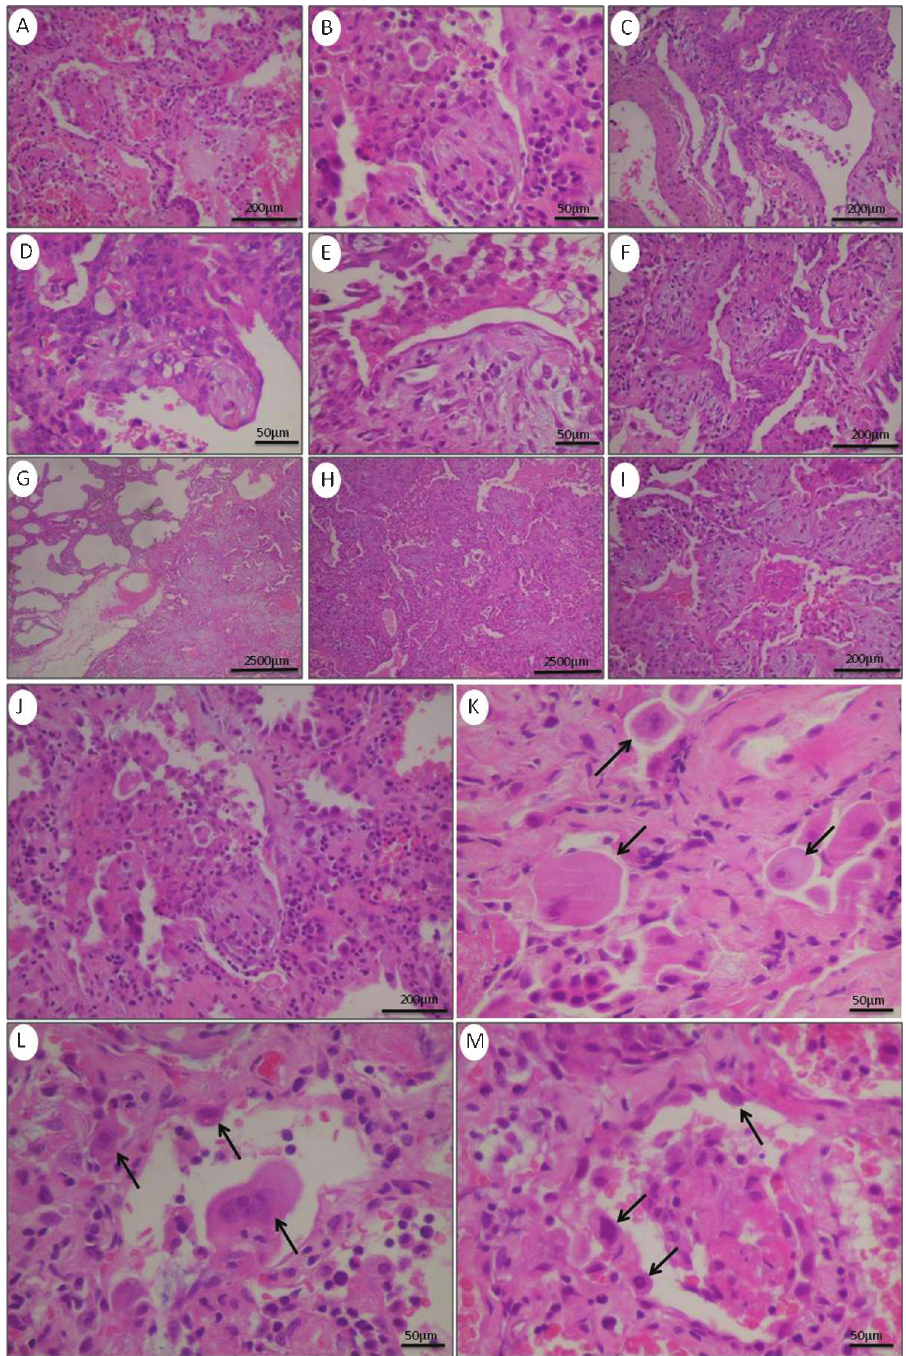
Figure 1 - Lung sections from N1H1 patients examined by Hematoxilyn Eosin staining. This panel show pulmonary parenchyma modified by extensive alveolar lesion characterized by alveolar hemorrhage (A), disproportionately sparse infiltrate of inflammatory cells (B) and collapse alveolar areas with dilatation of the airspaces (C). In other areas show diffuse alveolar damage with interstitial thickening (D), mild to moderate fibroplasia (E), hyaline membrane formation (F) and intra-alveolar fibrin exudates (G to I). Intra- alveolar fibrin exudates similar with moderate infiltrate of inflammatory cells characterized by histiocytes, lymphocytes, megakariocytes and multinucleated forms (J). These atypical forms included multinucleated giant cells with granular amphophilic cytoplasm, irregular, large and atypical nuclei and prominent eosinophilic nucleoli (arrows) (K to M), (Hematoxilyn